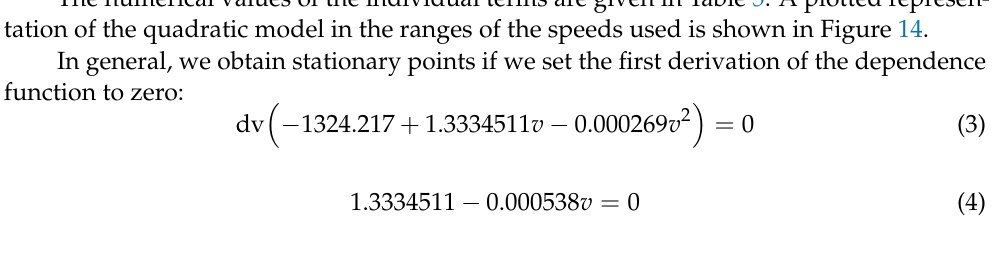
Figure 11. Dependence of the number of holes drilled up to the moment of tool damage and drilling time on speed used in the experiment.